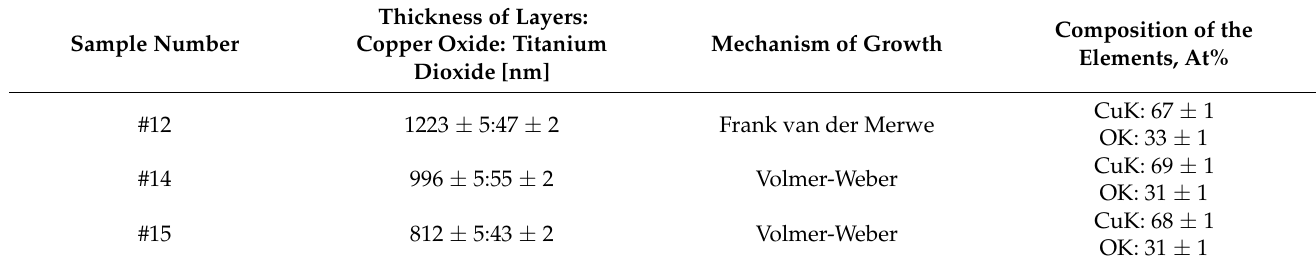
Table 4. The basic morphological parameters of deposited thin